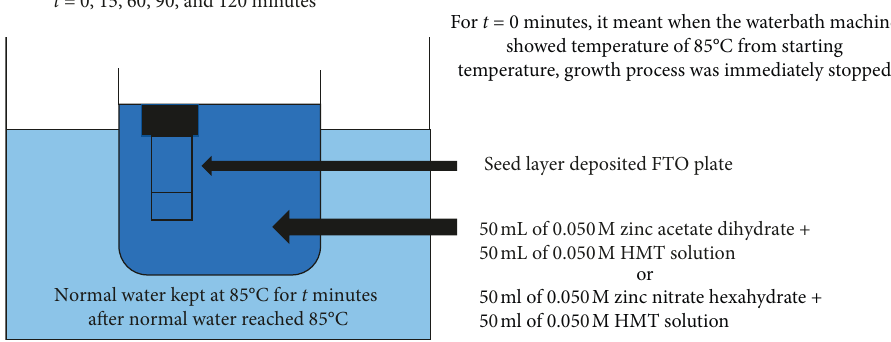
Figure 1: Growth of ZnO NRs with the waterbath method.